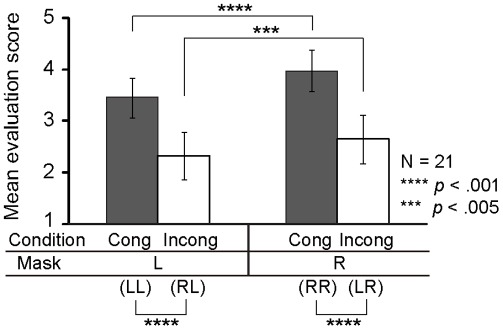
Mean evaluation scores in the practice phase.RR and LL conditions are congruent-green conditions and LR and RL conditions are incongruent-blue conditions. Error bars indicate the SDs of the evaluation scores across participants. Cong and Incong denote congruent-green and incongruent-blue conditions, respectively.